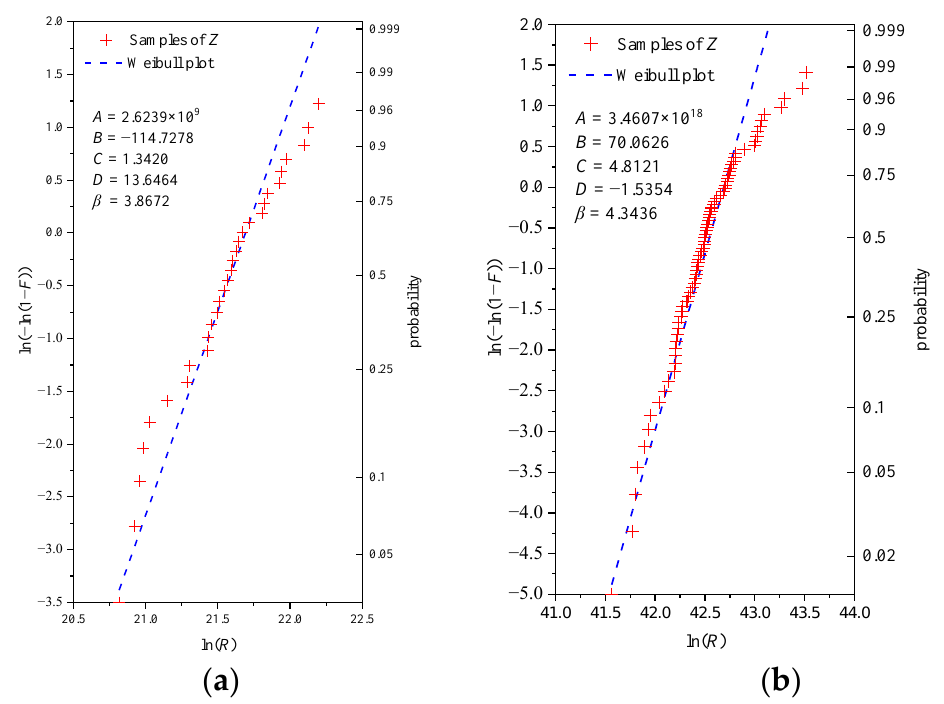
Figure 16. Weibull plot of the normalized variable R for corroded steel wire. ( a ) Δ S ≤ 360 MPa , ( b ) Δ S ≤ 360 MPa .